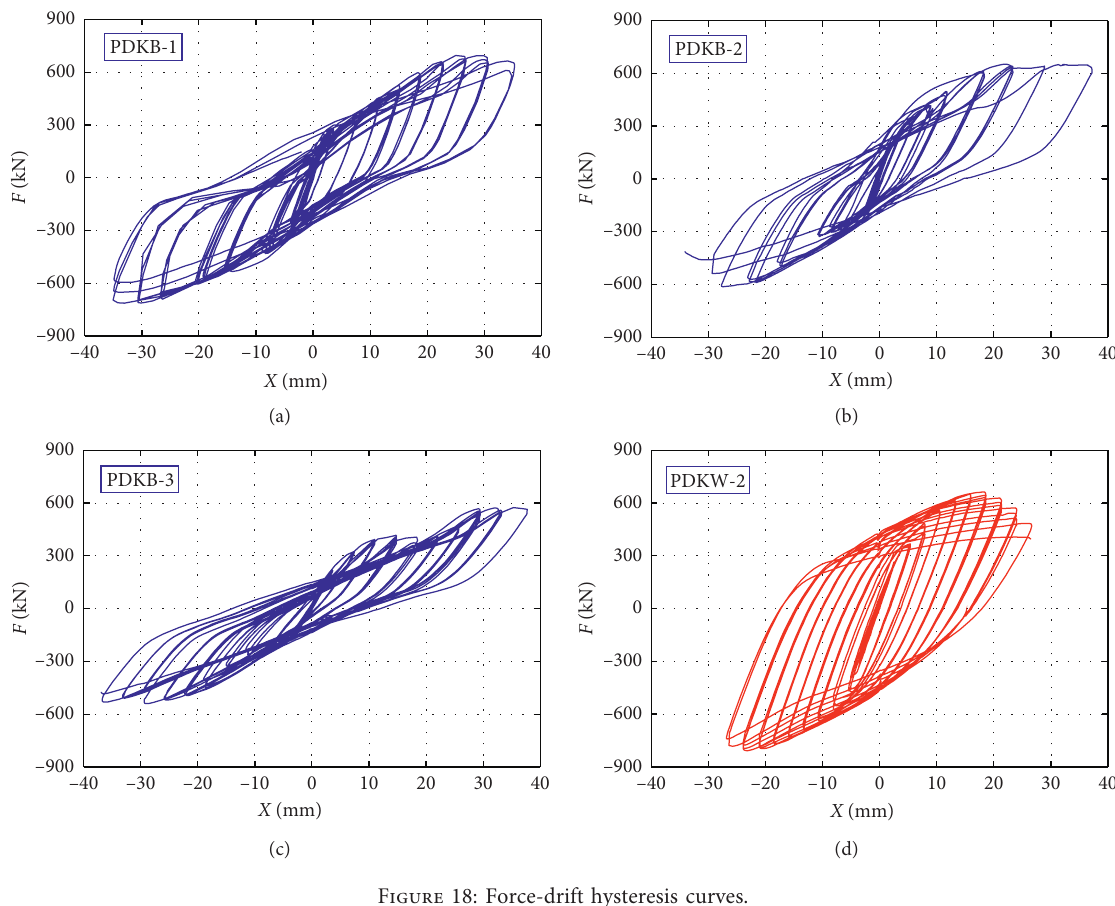
Figure 18: Force-drift hysteresis curves.